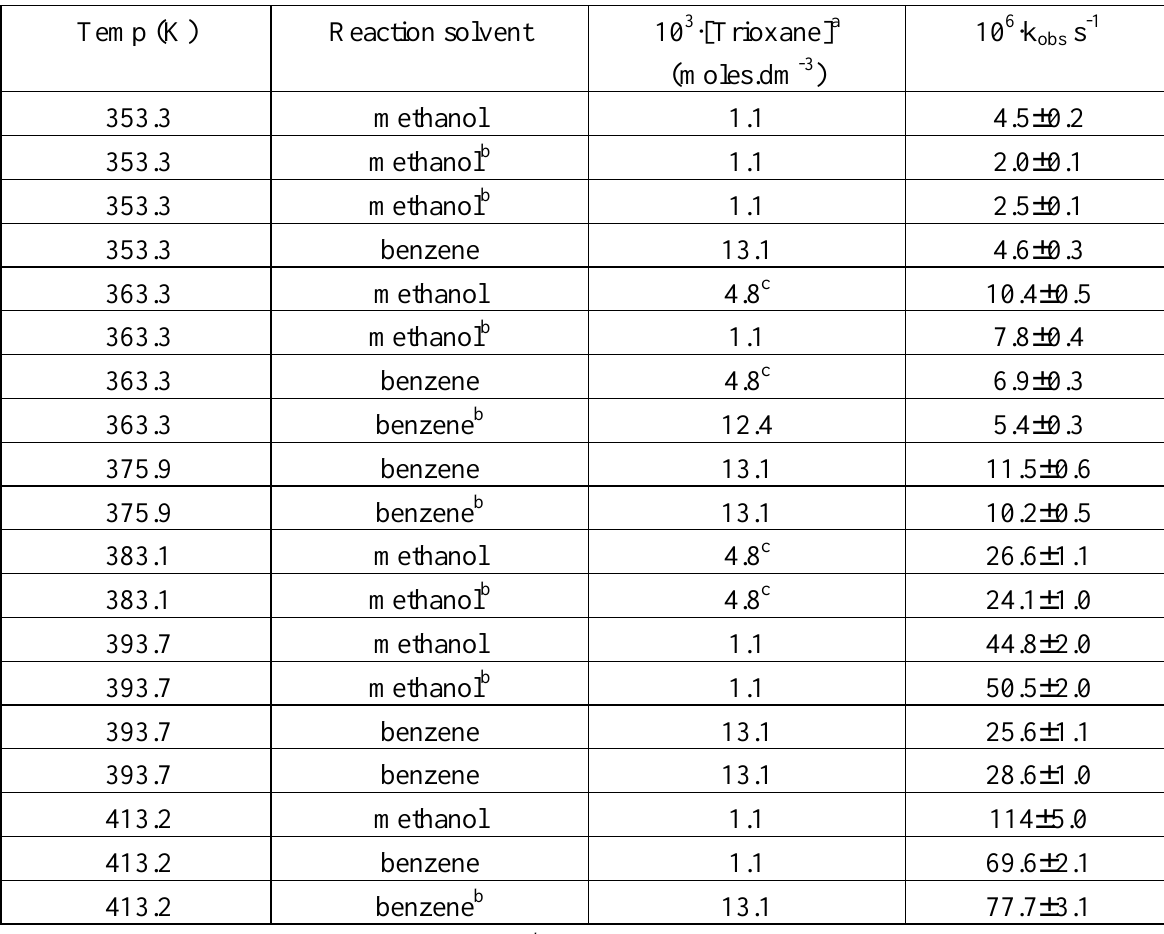
Table I. First-Order Rate Constant Values for the Thermal Decomposition Reactions of Ia in